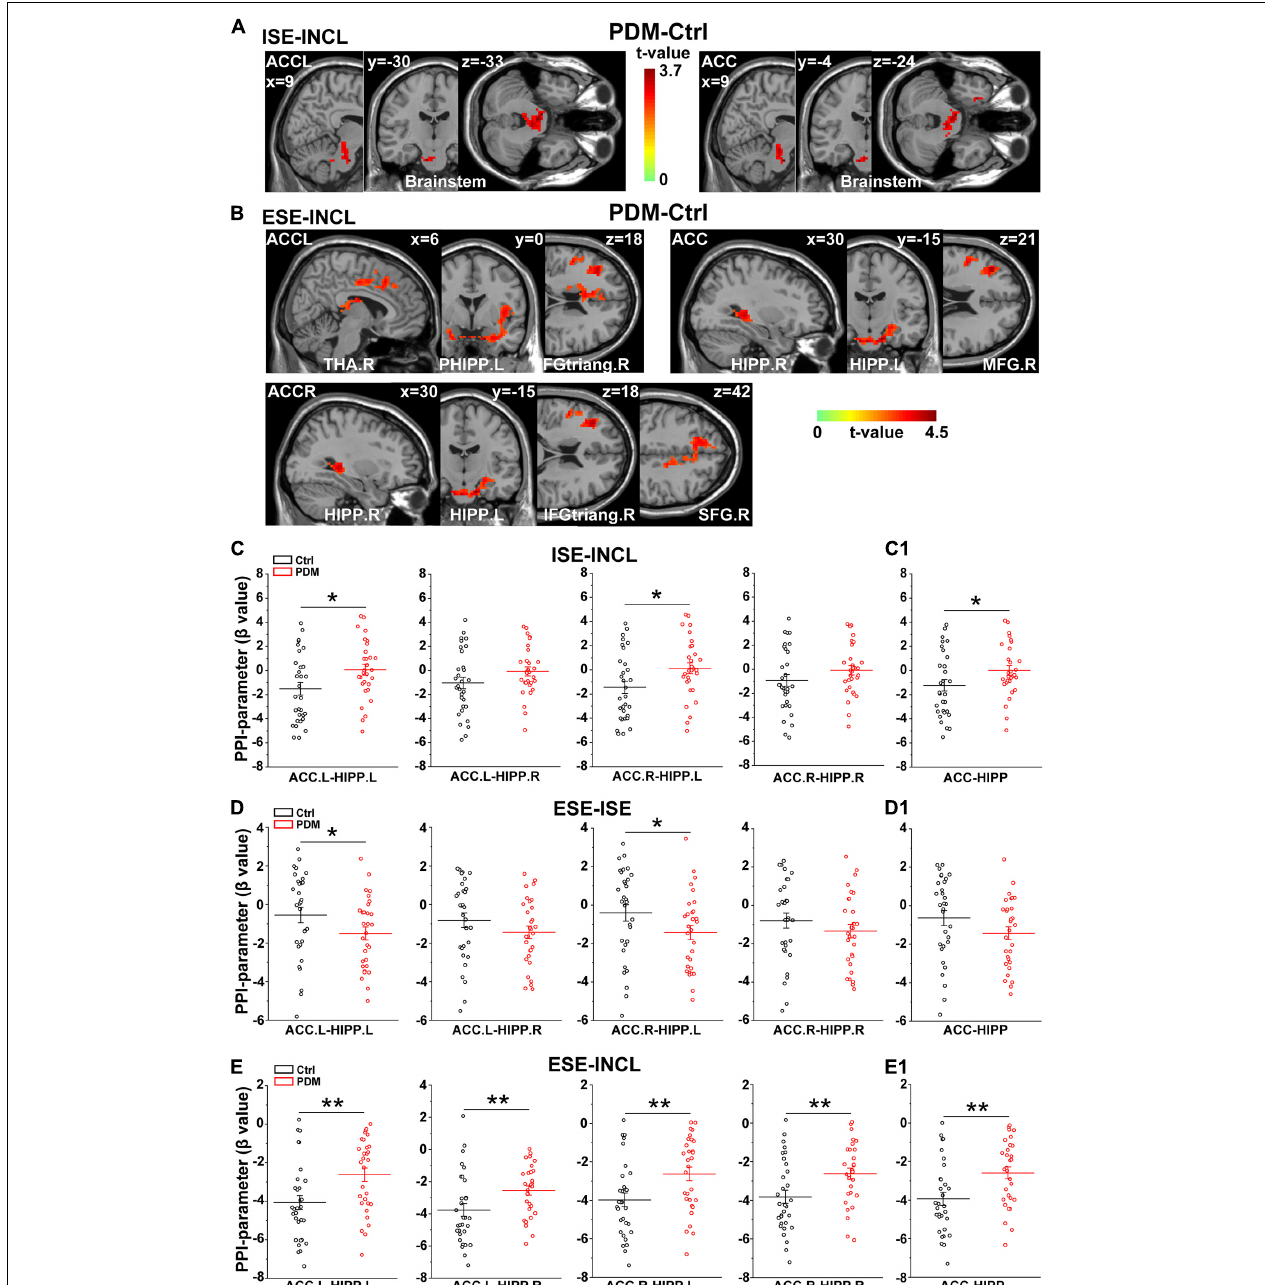
FIGURE 3 | Abnormal connectivity between ACC and HIPP in PDM females revealed by PPI analysis. (A,B) The PDM cohort has increased ACC connectivity in the ISE-INCL and ESE-INCL contrasts. In the ISE-INCL contrast (A) , PDM females show increased ACC.L/ACC connectivity with brainstem. In the ESE-INCL contrast (B) , PDM women demonstrate increased connectivity between ACC.L/ACC.R/ACC and other brain regions, including frontal cortex, thalamus, and HIPP. (C–E) The PDM group exhibits a significant difference in ACC-HIPP connectivity compared to controls. For the ISE-INCL contrast (C) , PDM subjects show increased ACC.L-HIPP.L and ACC.R-HIPP.L connectivity. ACC.L-HIPP.R and ACC.R-HIPP.R connectivity is identical. In the ESE-ISE contrast (D) , the PDM group show decreased connectivity for the ACC.L-HIPP.L and ACC.R-HIPP.L circuits. ACC.L-HIPP.R and ACC.R-HIPP.R connectivity is also identical. In the ESE-INCL comparison (E) , PDM subjects demonstrate increased connectivity for all ACC-HIPP combinations. Combining the bilateral regions also shows that PDM women have an overall increased ACC-HIPP connectivity in the ISE-INCL contrast (C1) and the ESE-INCL contrast (E1) ; and no significant difference in the ESE-ISE contrast (D1) . Given that the PPI value is negative, the increased ACC-HIPP connectivity in the PDM indicated less connectivity reduction in the ISE-INCL and ESE-INCL contrast. L/R, left/right hemisphere; n = 30 and 31 for PDM and control females, respectively. The color bar represents the t -value. Error bars = ± 1 SEM. Two-sample t -test and Gaussian Random Field (GRF) correction with voxel-wise threshold of p < 0.01 and cluster threshold of p < 0.05 were used to determine the significantly abnormal brain regions functionally connected with ACC.L/ACC.R/ACC. A non-parametric permutation test was used for the specific ACC-HIPP connectivity with p < 0.05. * p < 0.05; ** p <